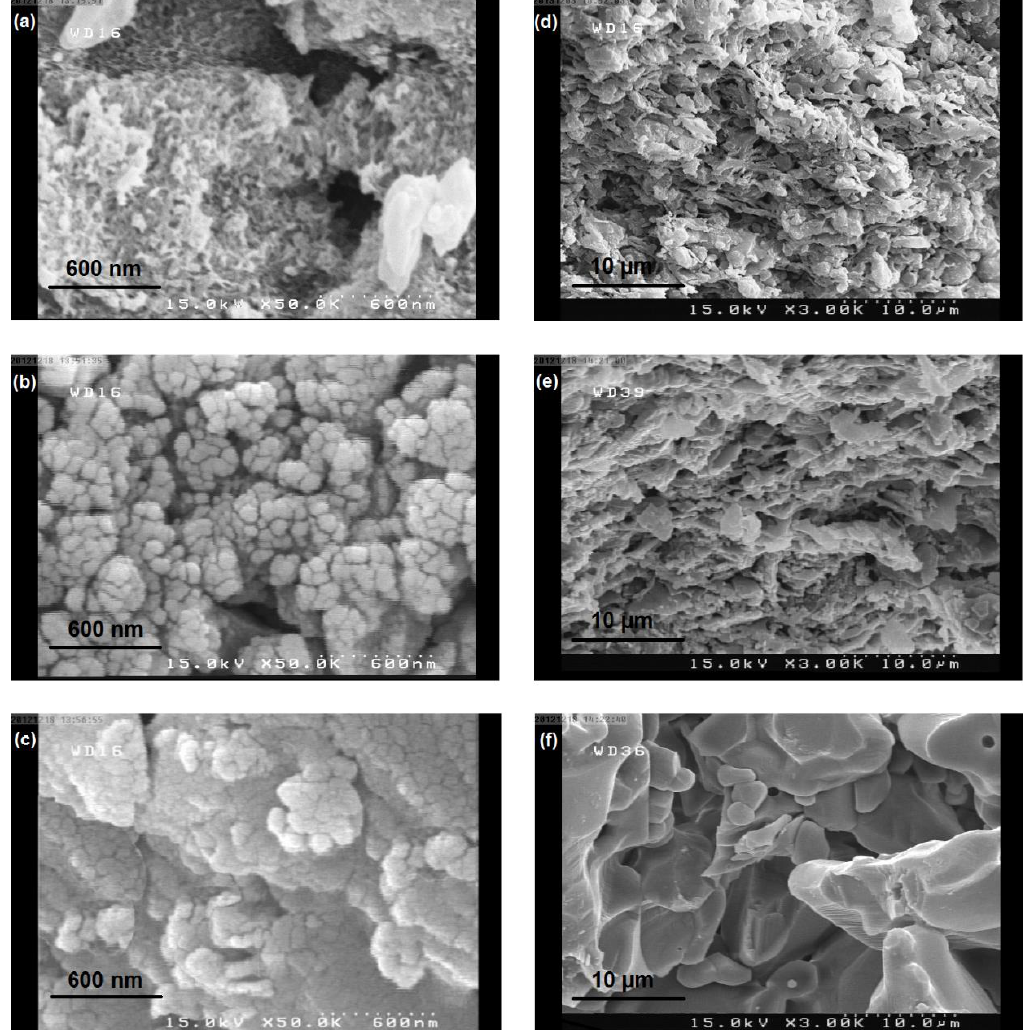
Figure 3. The FE-SEM images of the surface of supports: ( a ) mullite; ( b ) mullite-alumina; ( c ) α-alumina, cross-section of supports: ( d ) mullite; ( e ) mullite-alumina; ( f ) α-alumina.